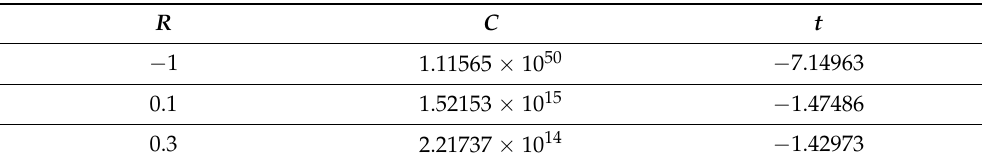
Table 5. The parameters of C and t at different R .